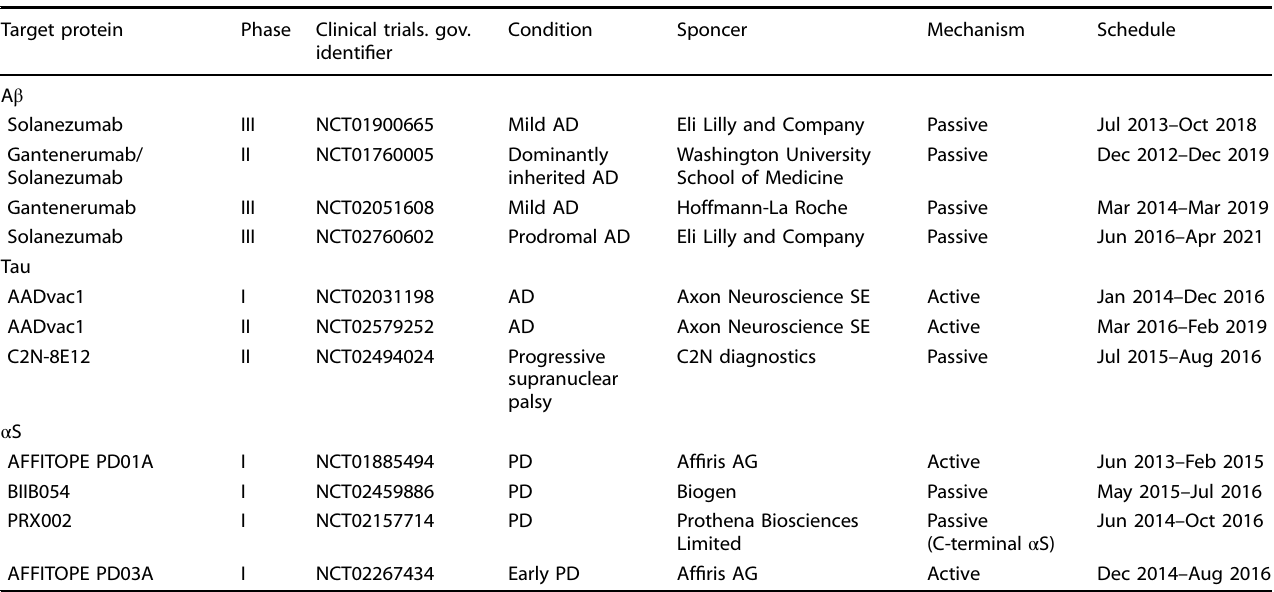
Table 1. Examples of recent clinical trials of immunotherapy in AD and PD Target